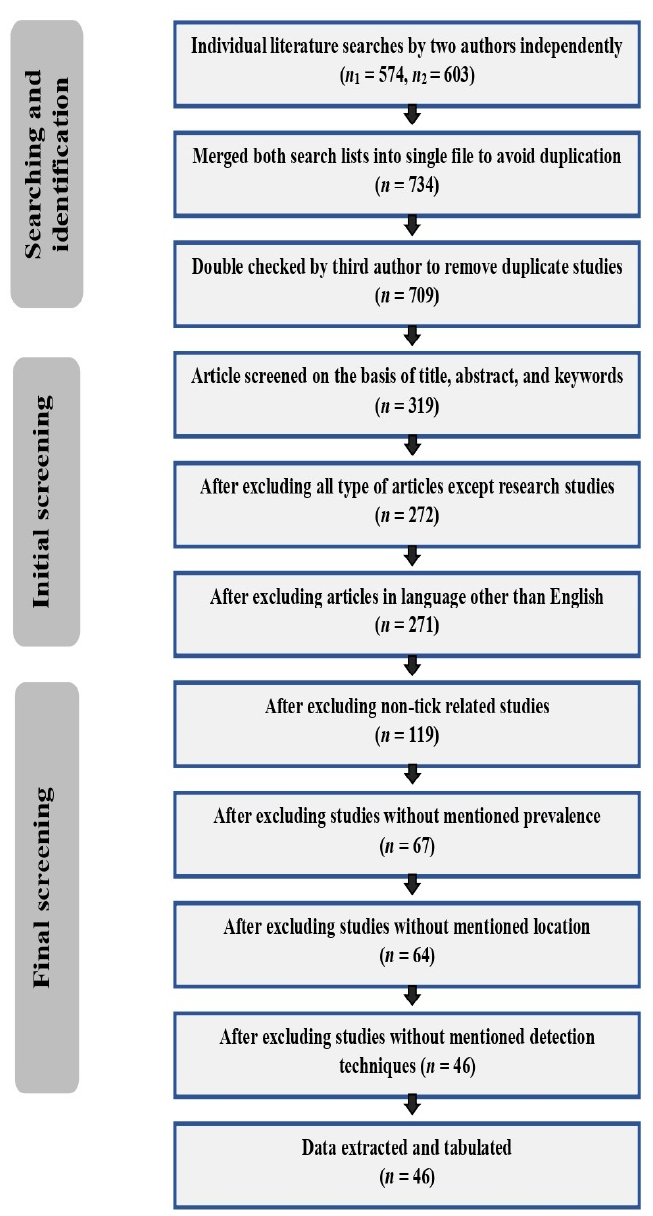
Figure 1. An overview of the selection procedure for studies recruited to this review according to